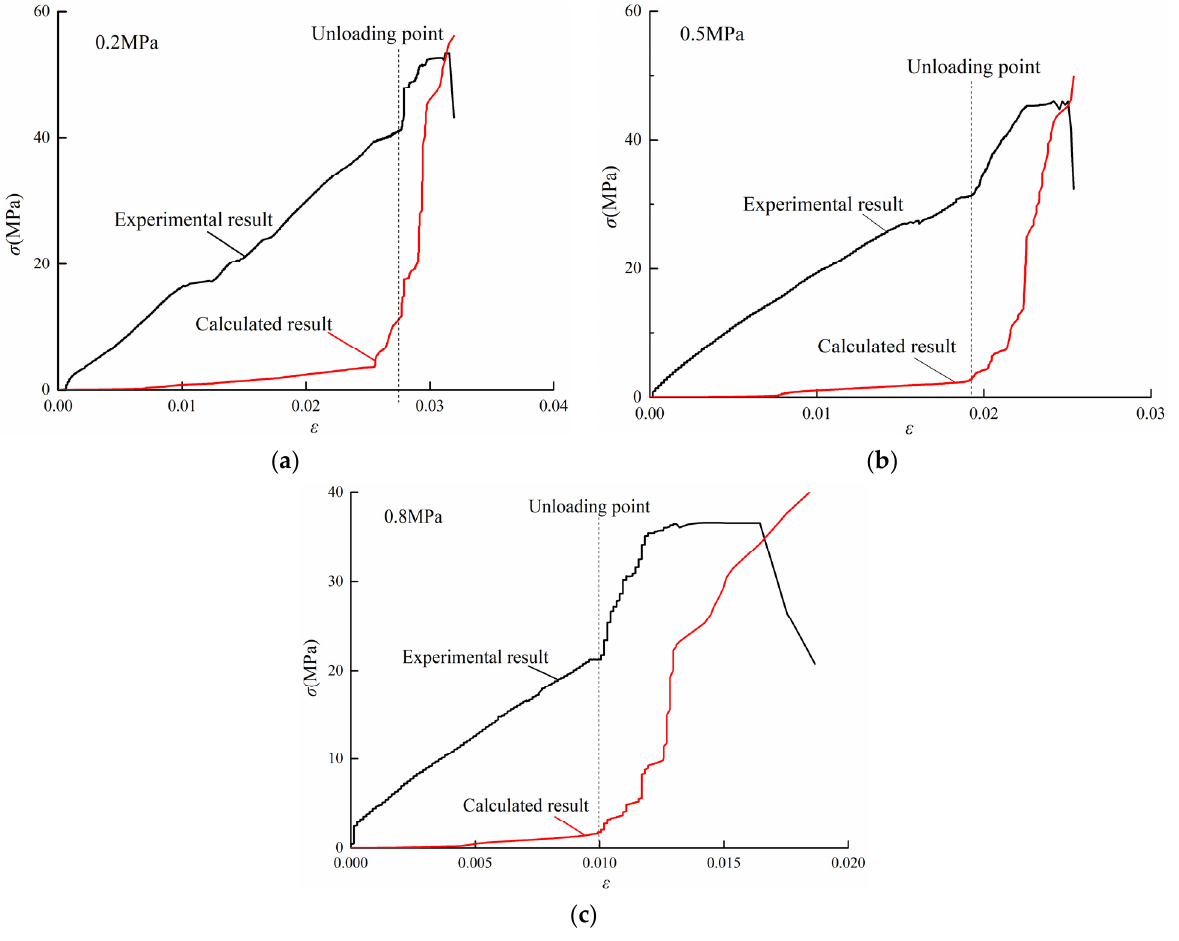
Figure 12. Calculated stress and measured stress for the unloading test. ( a ) Gas pressure of 0.2 MPa. ( b ) Gas pressure of 0.5 MPa. ( c ) Gas pressure of 0.8 MPa.